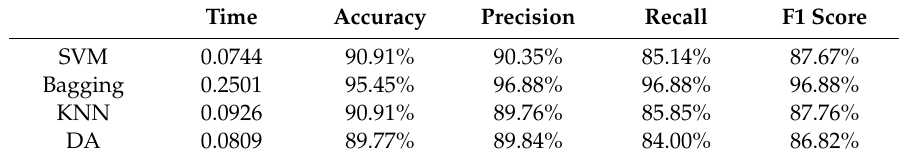
Table 2. Performance of the four learners in terms of time, accuracy, precision, recall and F1